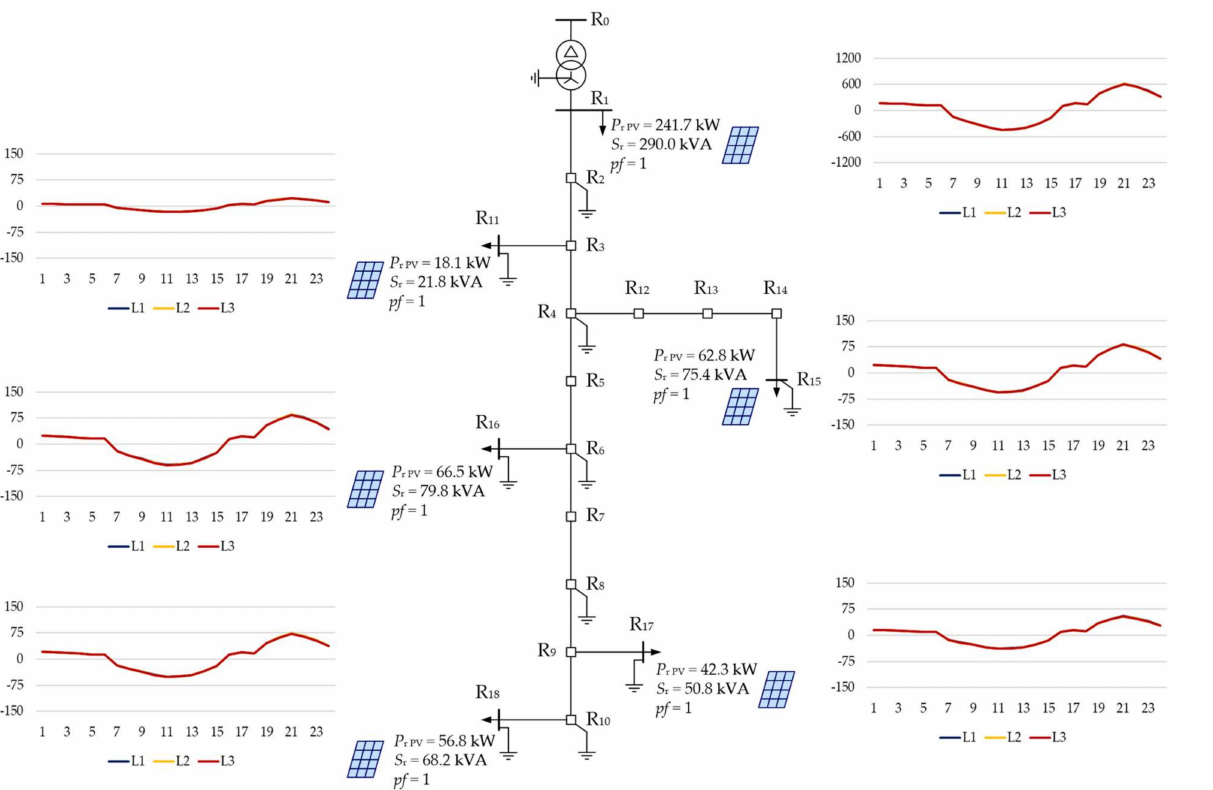
Figure 15. Daily simulation results showing the phase currents (A) in the test network for variant V2.